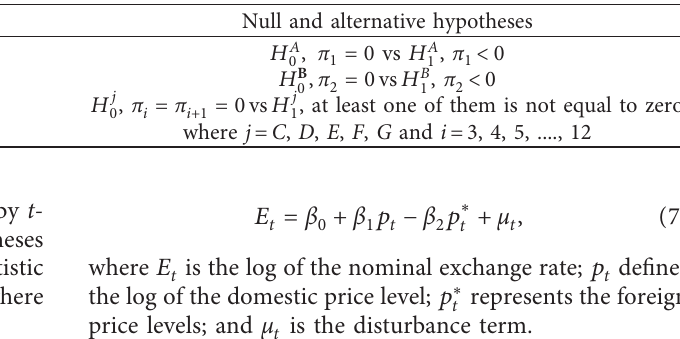
Table 1: Null and alternative hypotheses for monthly unit root